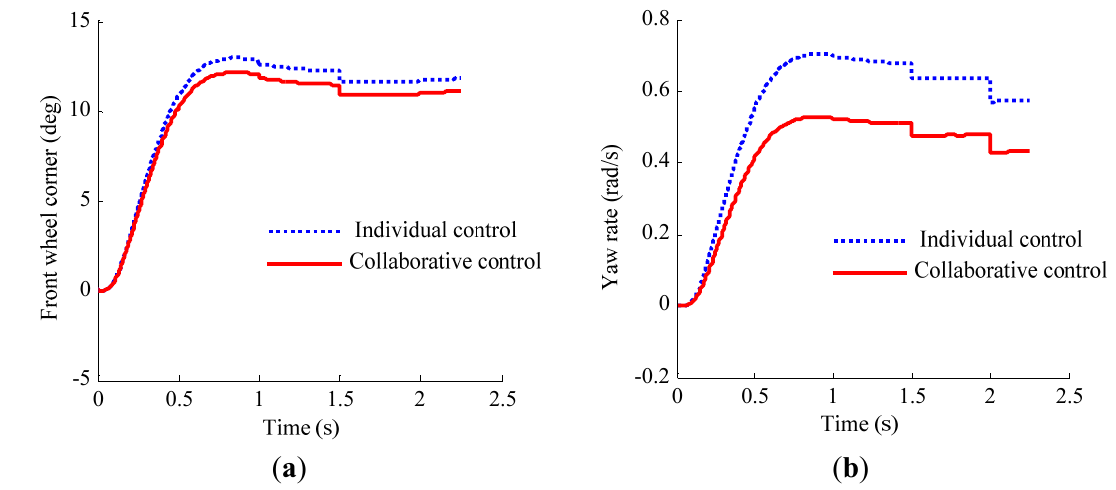
Figure 6. Simulation results of vehicle front wheel corner and yaw rate: ( a ) Front wheel corner; ( b ) Yaw rate.